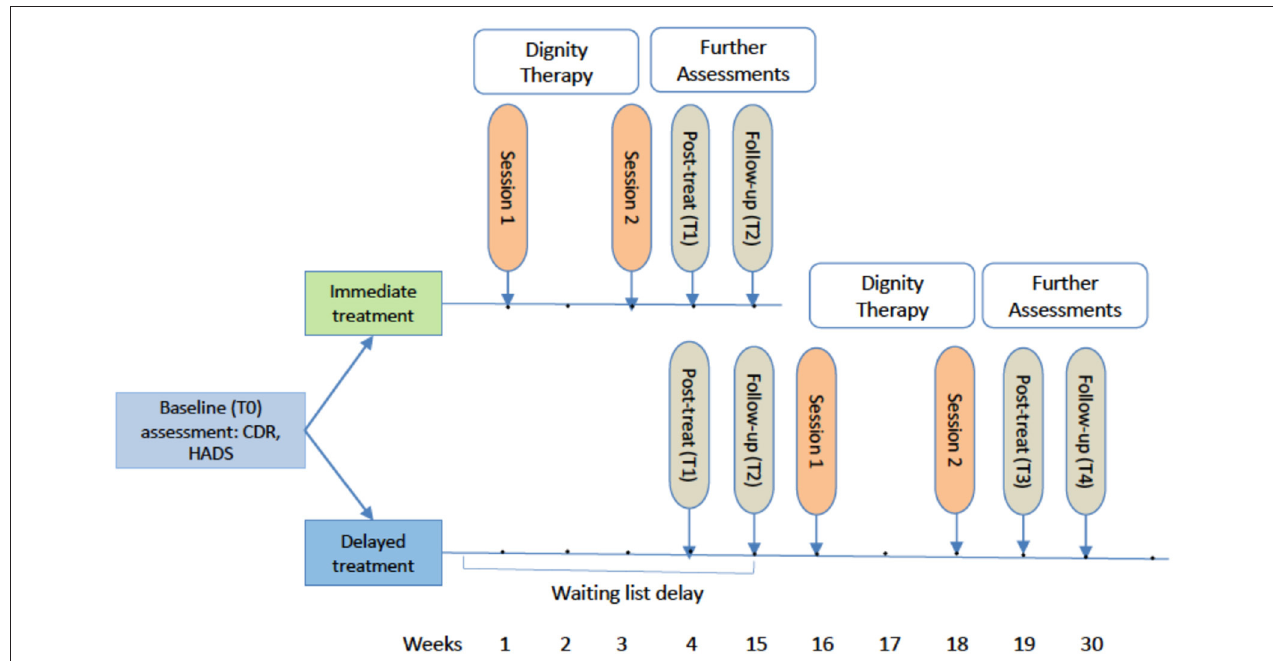
FIGURE 1 | Study timeline from baseline assessment to the 1-week post-treatment and 3-months follow-up. T0, Baseline; T1, post-treatment; T2, 3-months follow-up; T3, post-treatment delayed group; T4, 3-months follow-up delayed group; CDR, Clinical Dementia Rating; HADS, Hospital Anxiety and Depression